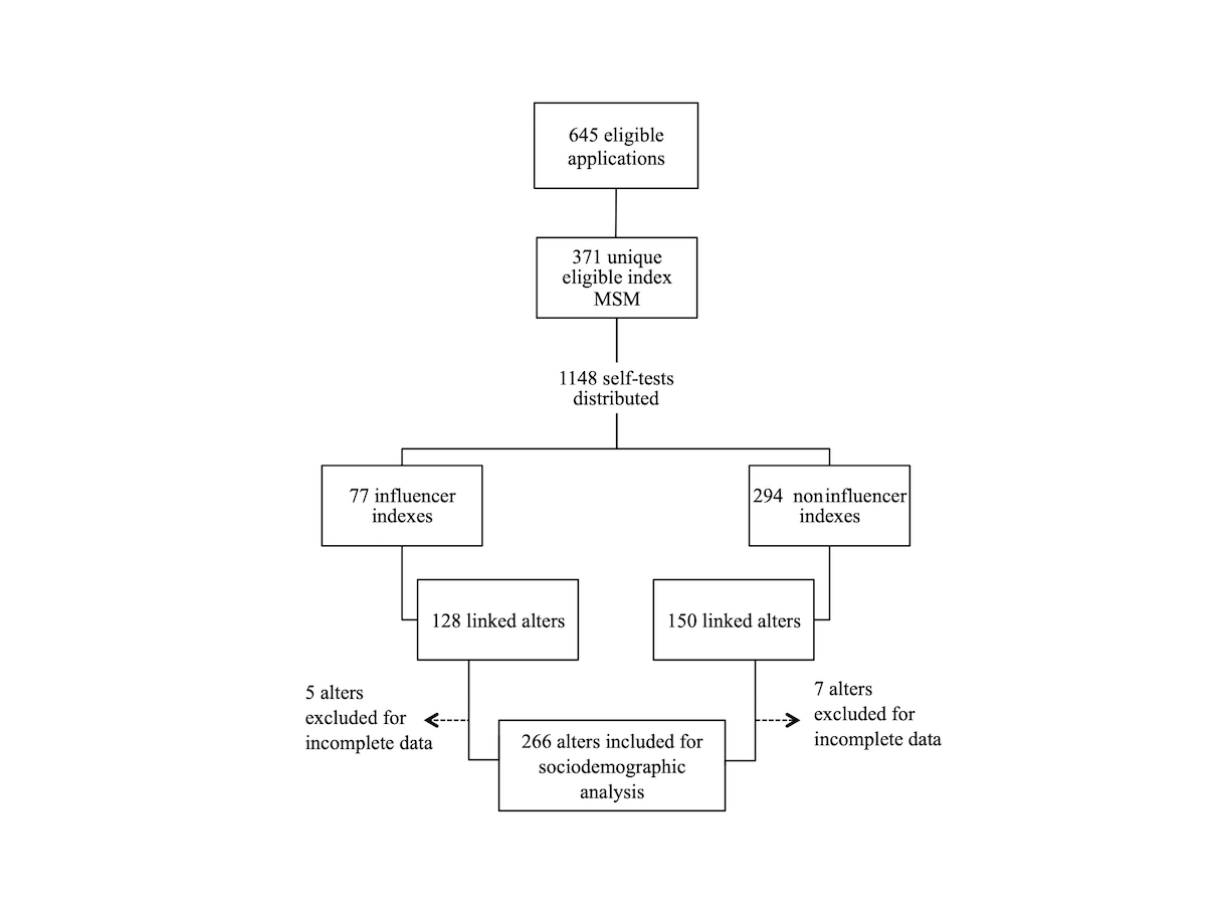
Figure 2. Flowchart of study